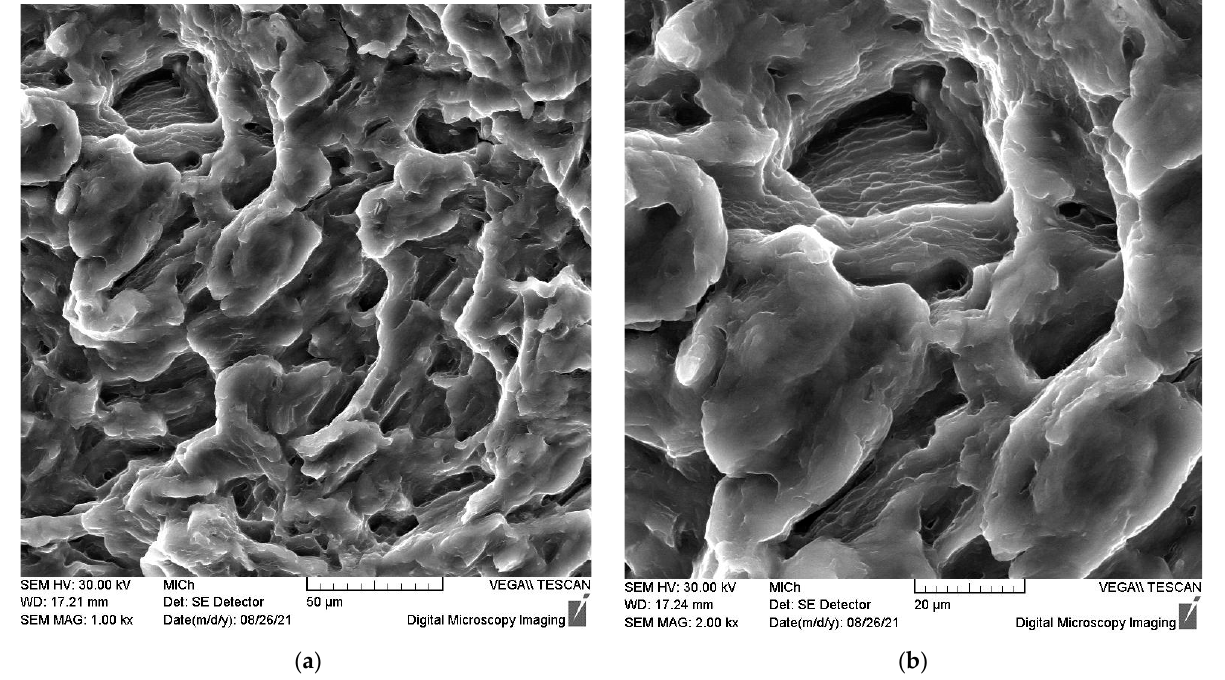
Figure 19. Scanning electron micrograph taken from the transition region ( a ), dimple on the fracture surface with fine striations inside ( b ).